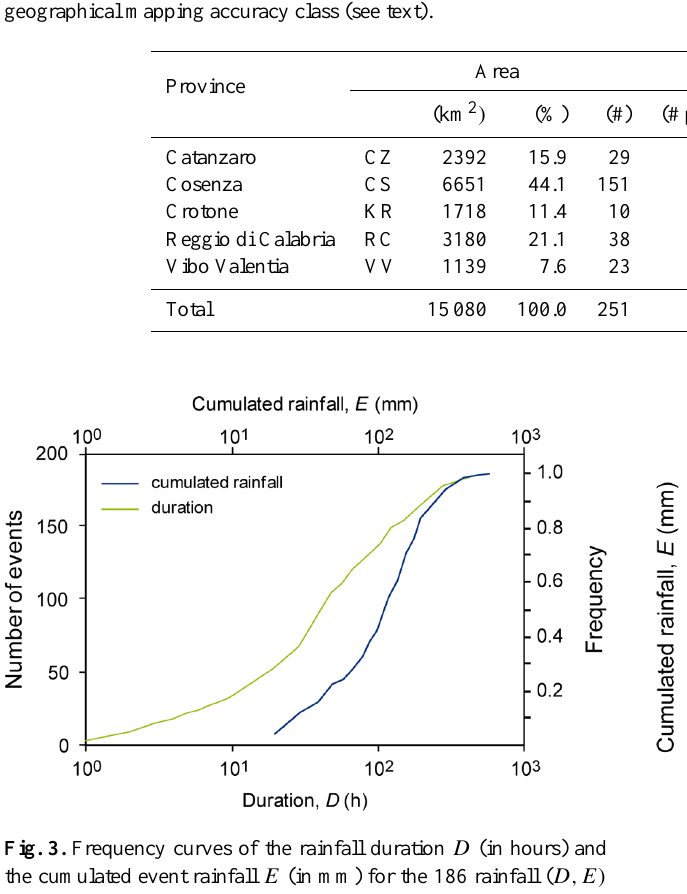
Fig. 4. Rainfall duration vs. cumulated event rainfall ( D,E) con- ditions that resulted in shallow landslides in Calabria (blue dots), and related ED threshold at the 5% exceedance probability level. Inset shows the threshold in linear coordinates. Shaded areas show uncertainties associated with the